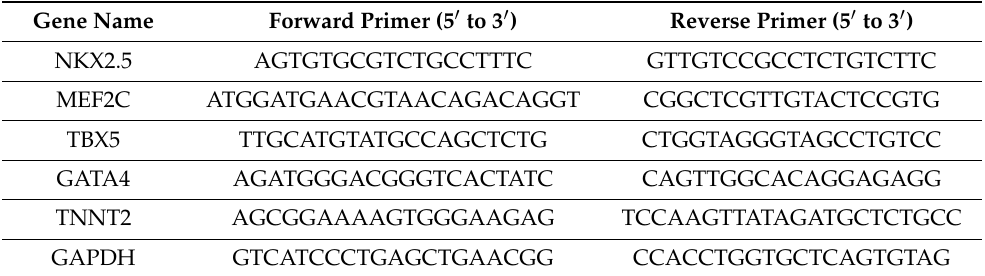
Table 2. Quantitative reverse transcription polymerase chain reaction (qRT-PCR) primers used in this